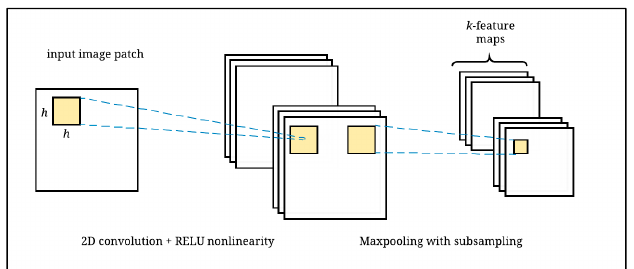
Figure 2. An illustration of the convolutional layer of the proposed architecture. The receptive fields have a dimension of h × h .